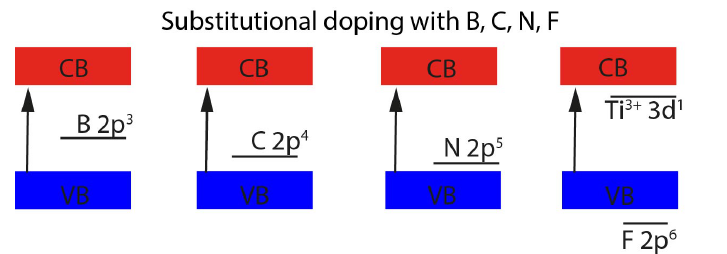
Figure 5. Schematic representation of the energy levels for substitutional doping in TiO 2 .